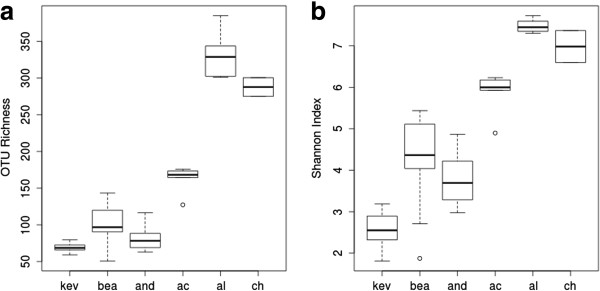
Alpha diversity metrics for each sampling location, rarefied to the 1,000-sequence level (n = 48). (a) Boxplots of OTUs0.03 richness and (b) boxplots of the Shannon diversity index, both at the 97% sequence similarity threshold.